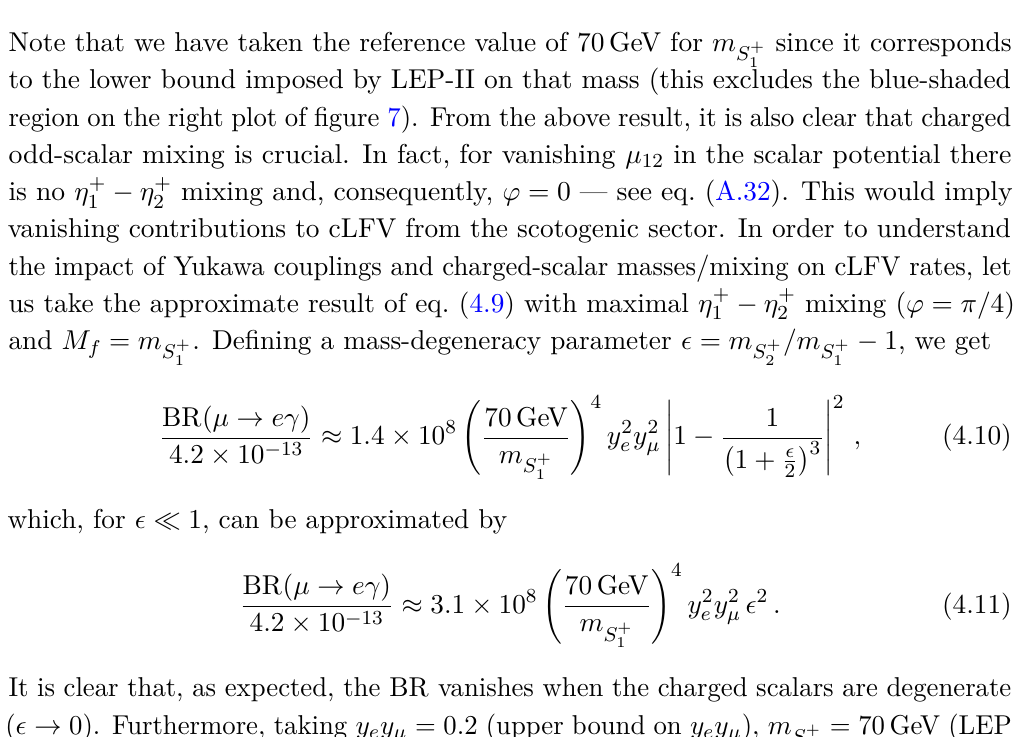
Figure 7 . BR( µ → eγ ) as a function of the Yukawa couplings product y e y µ , on the left, and, in terms of the lightest dark charged scalar mass m , on the right. We use the same colour code as in S + 1 figure 6 to indicate the current bound and projected sensitivity for BR( µ → eγ ) showed in table